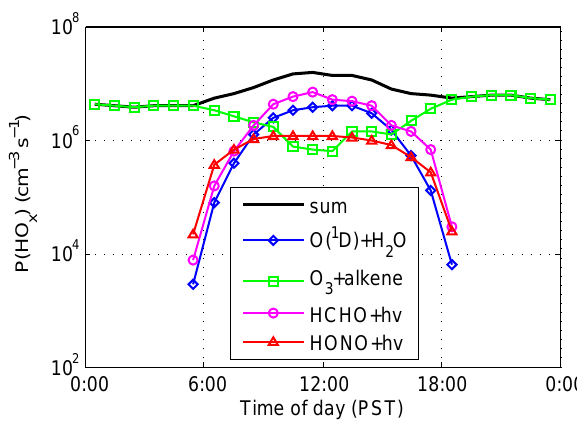
Fig. 9. Diurnal variation of HO x production rates from the photoly- sis of ozone followed by the consequent O( 1 D)+H 2 O reaction (dia- monds), the photolysis of HCHO (circles), the photolysis of HONO (triangles), and from the reactions of O 3 +alkenes